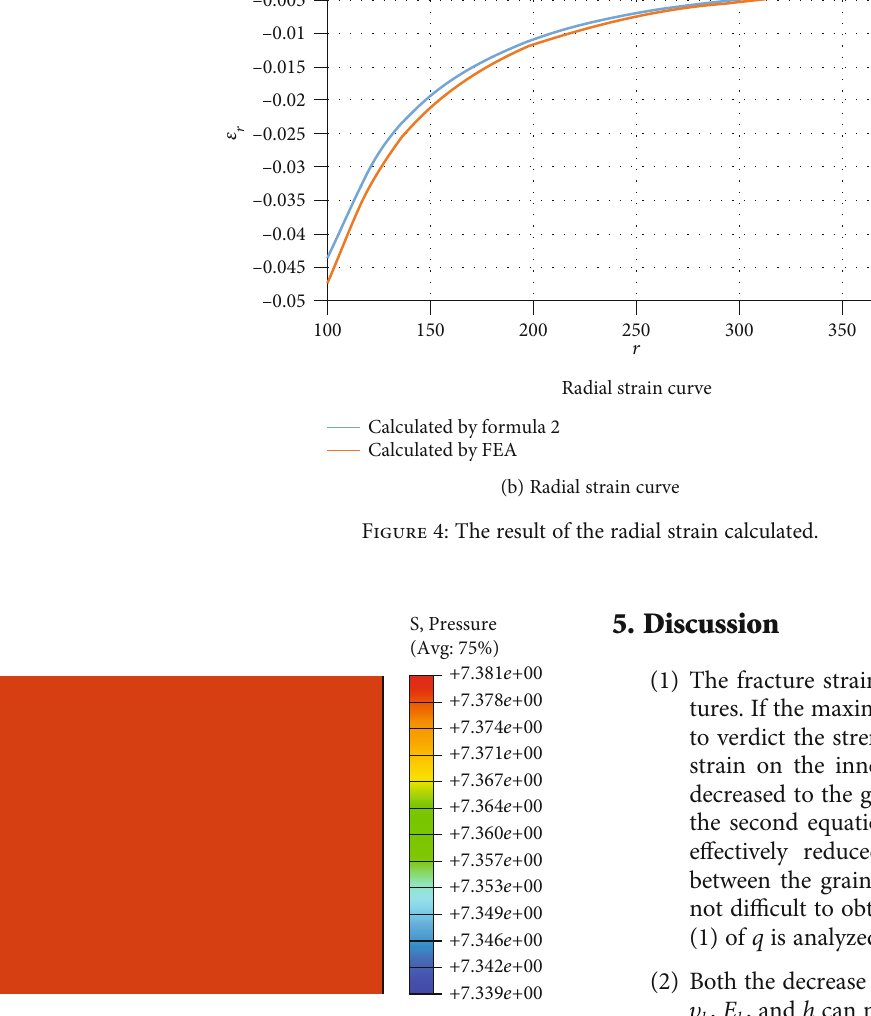
Figure 5: The pressure distribution of the